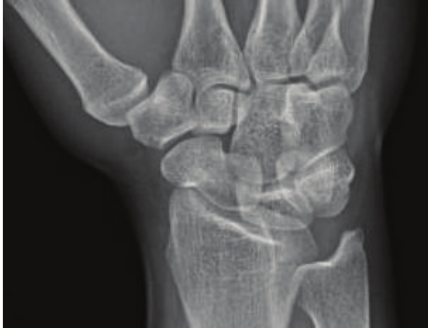
Figure 2: An oblique radiographic view at the time of initial evaluation without evidence of abnormality of the scaphoid.